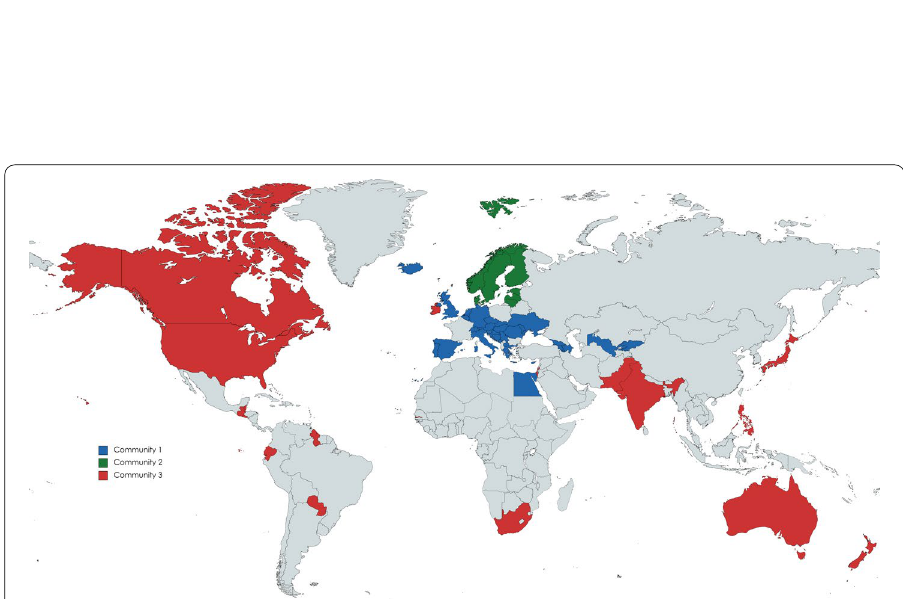
Fig. 11 World map with the communities obtained by applying the Louvain method in